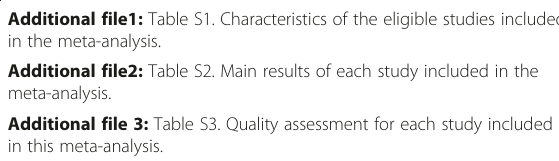
Additional file1: Table S1. Characteristics of the eligible studies included in the meta-analysis. Additional file2: Table S2. Main results of each study included in the meta-analysis. Additional file 3: Table S3. Quality assessment for each study included in this meta-analysis.